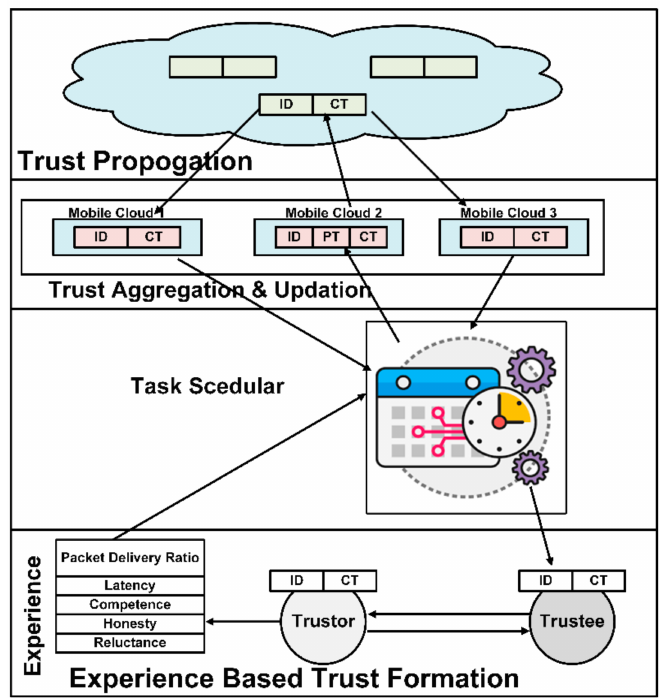
Figure 6. Mobile task scheduling and trust